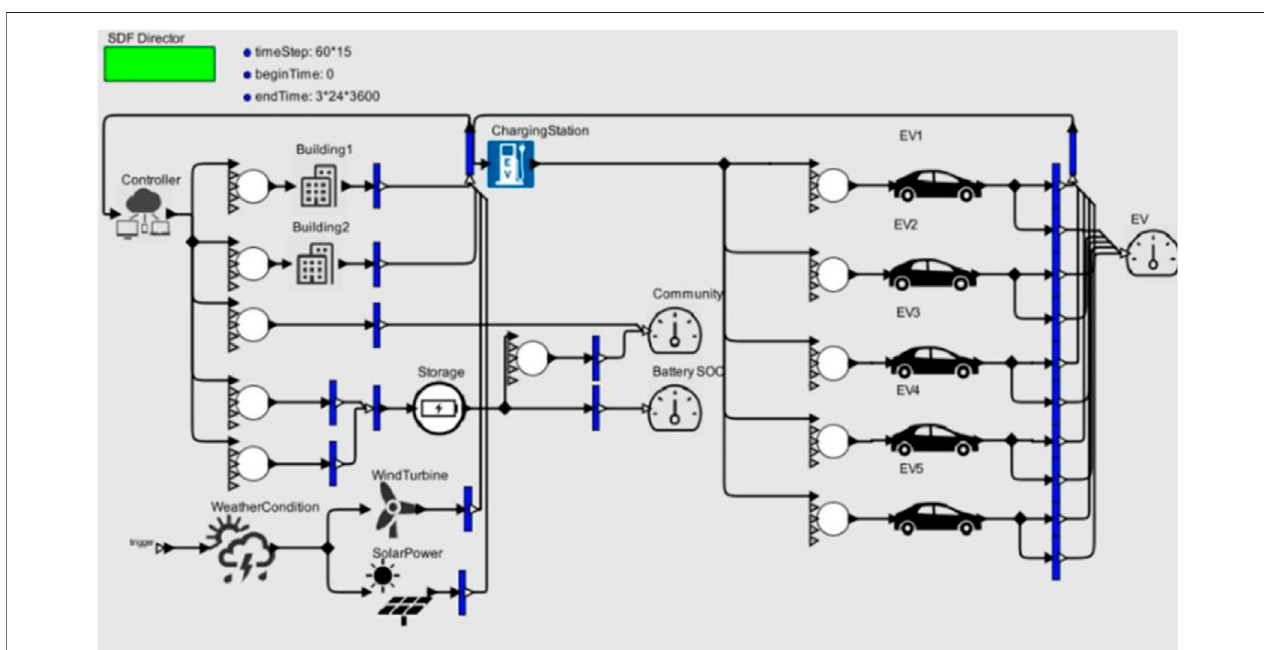
FIGURE 8 | A co-simulation example representing a small-scale smart